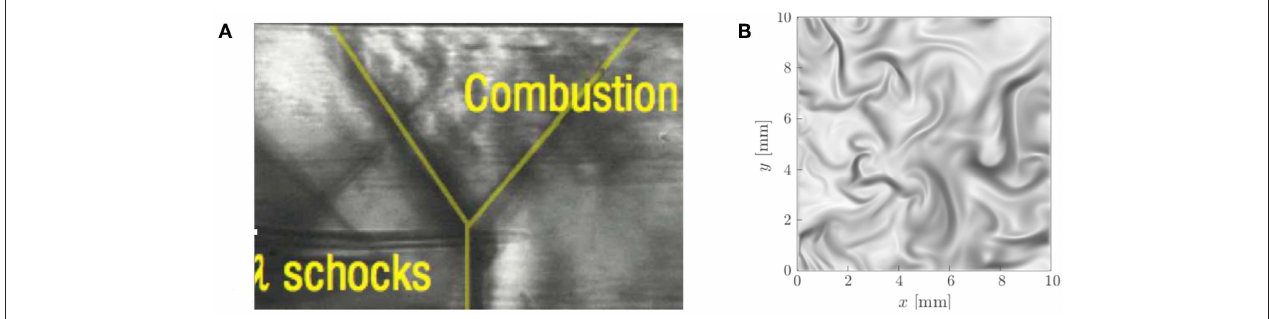
FIGURE 11 | (A) Schlieren picture from a scramjet combustor experiment (adapted from Scherrer et al., 2016 with permission from them) and (B) numerical Schlieren from the case NP3, adapted from Doan and Swaminathan (2019a) under a Creative Commons